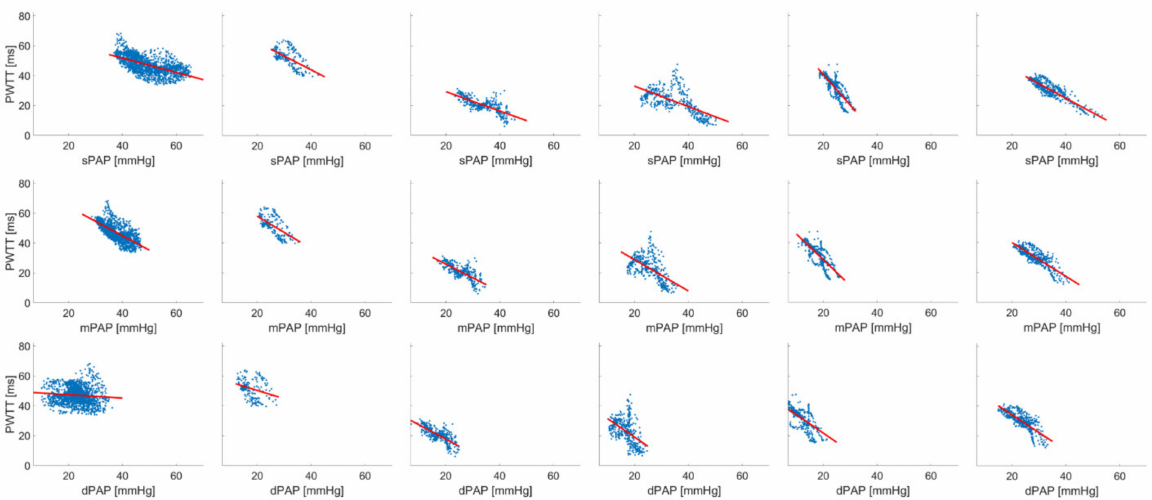
Figure 4. Inverse linear correlation between sPAP, mPAP, dPAP and PWTT during thromboxane A2-induced PH in six pigs. Average correlation coefficient was calculated via Fisher’s-Z transformation (sPAP r = 0.742 ± 0.104, mPAP r = 0.712 ± 0.078 and dPAP r = 0.609 ± 0.179). Linear regression was performed by least square method.